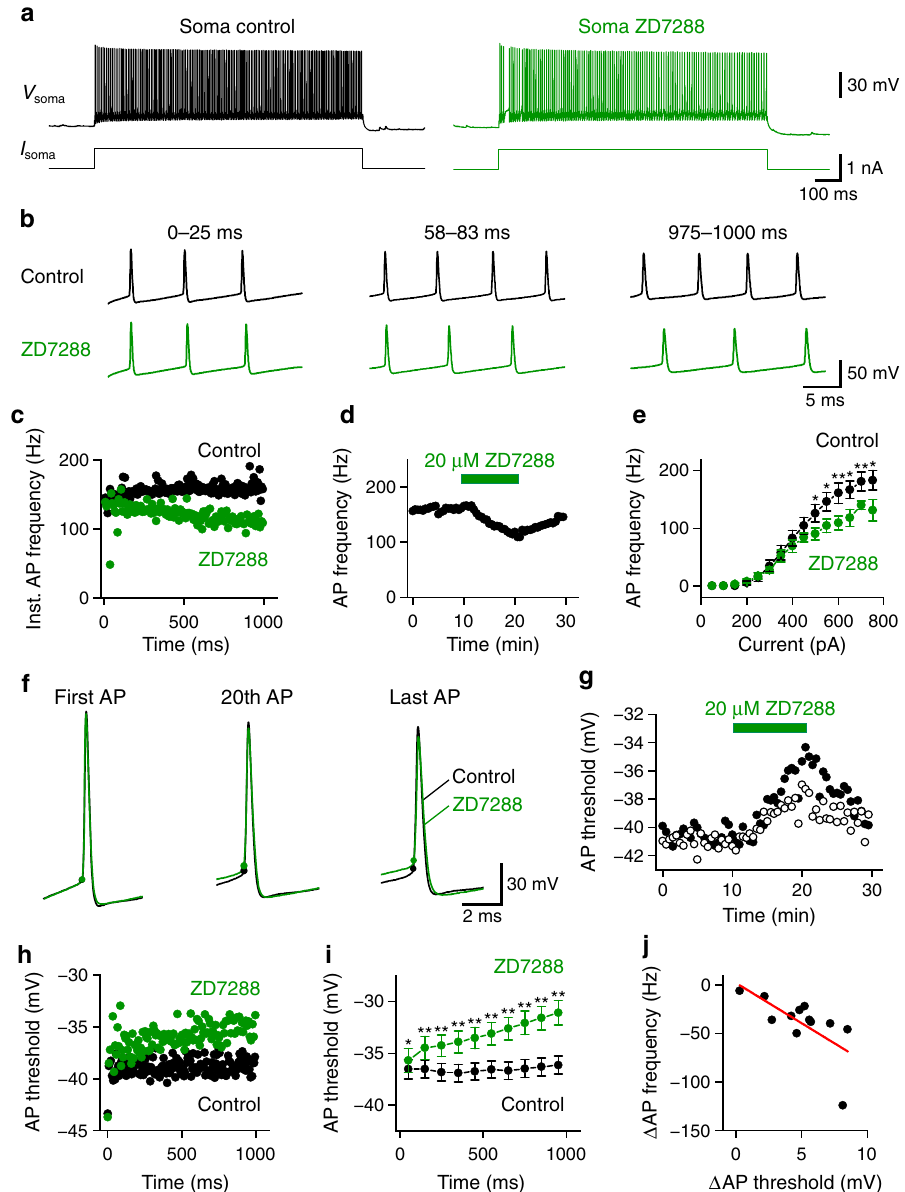
Fig. 2 HCN channels enhance AP initiation during sustained high-frequency fi ring. a Somatic recording of AP trains evoked by injecting a 1-s current pulse into the soma of a PV + -BC in control (black) and 20 µ M ZD7288 (green). b Membrane potentials in a plotted on an expanded time scale to compare AP frequencies in three different time windows (0 – 25, 58 – 83, and 975 – 1000 ms from the onset of the current pulse). c Instantaneous AP frequency in control (black) and ZD7288 (green) plotted against the time from the onset of the current pulse to show spike frequency adaptation in ZD7288. d Steady- state AP frequency plotted against experimental time. e Summary plot comparing the input – output relationship of PV + -BCs in control (black) with that in 20 µ M ZD7288 (green). n = 12, 11, 10, and 9 PV + -BCs, when the somatic depolarizing current pulse amplitude was 50 – 550, 600, 650 – 700, and 750 pA, respectively. f First, the 20th and last APs from the spike train in a in control (black) superimposed over those in ZD7288 (green). Filled circles indicate respective AP threshold. g Somatic voltage threshold of the 20th (open circles) and last ( fi lled circles) APs in the train plotted against experimental time. h Somatic voltage threshold from the spike trains in a plotted against time from the onset of the 1-s current pulse. Data in a – d and f – h are from the same recording. i Same as in h , but shows the summary from 13 PV + -BCs in control (black) and 20 µ M ZD7288 (green). For clarity, we divided the 1-s train into 10 equally spaced time bins and calculated the mean threshold value of each bin ( n = 13 PV + -BCs). j Relationship between the 20 µ M ZD7288-induced AP frequency reduction and the elevation of somatic voltage threshold. Data were fi t with a linear function (red line, Spearman ρ = − 0.73, P = 0.01, n = 12 PV + -BCs). Error bars in this fi gure represent ± SEM. * indicates P = 0.01 – 0.04, ** indicates P = 0.002 – 0.009 in two-sided Wilcoxon signed rank test. Source data are provided as a Source data fi